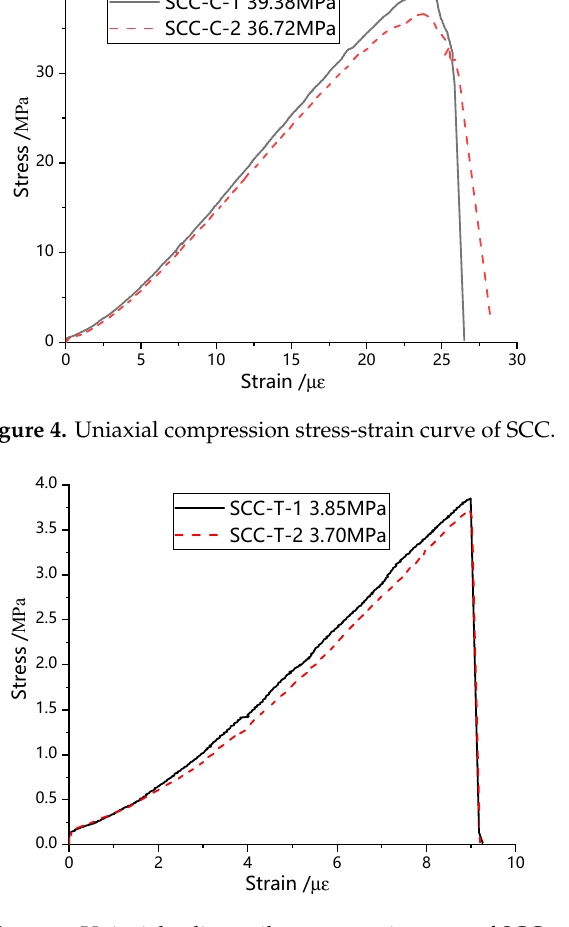
Figure 5. Uniaxial split tensile stress-strain curve of SCC.